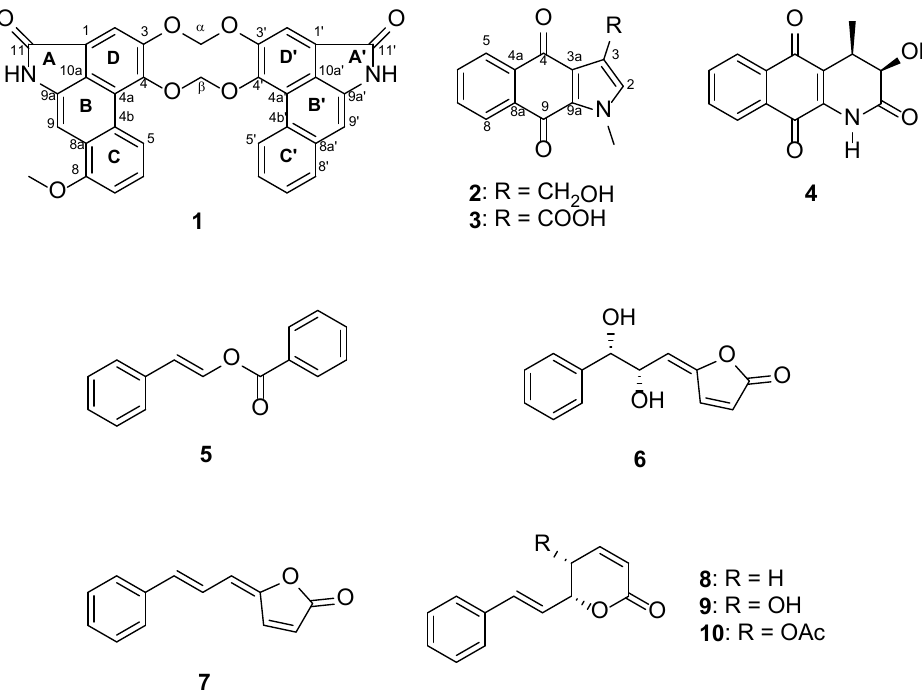
Figure 1. Compounds isolated from the twig extract of G. ridleyi.